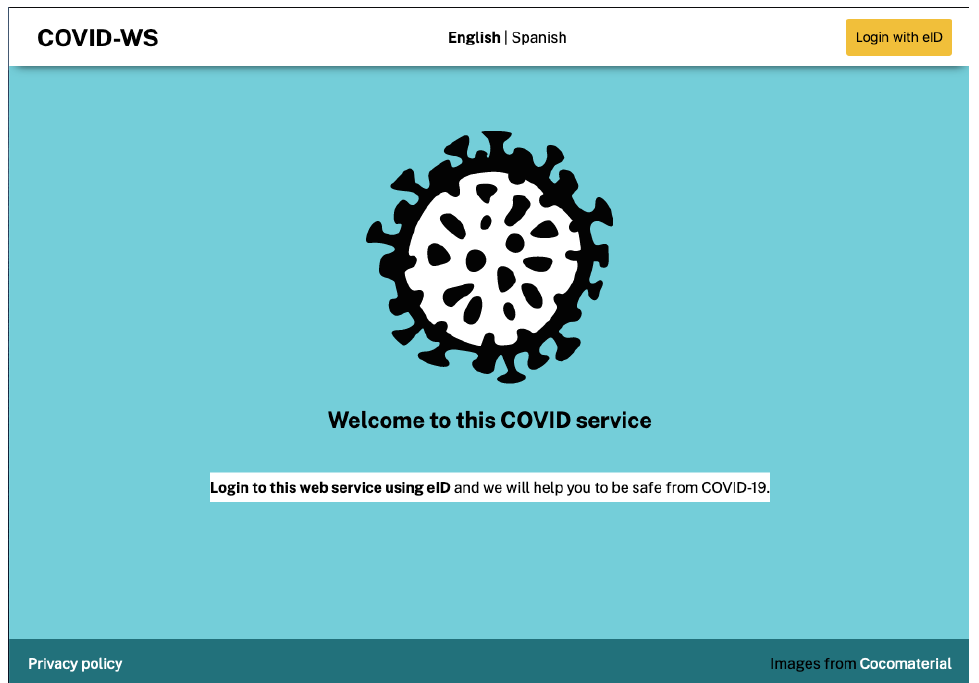
Figure 7. COVID information service login